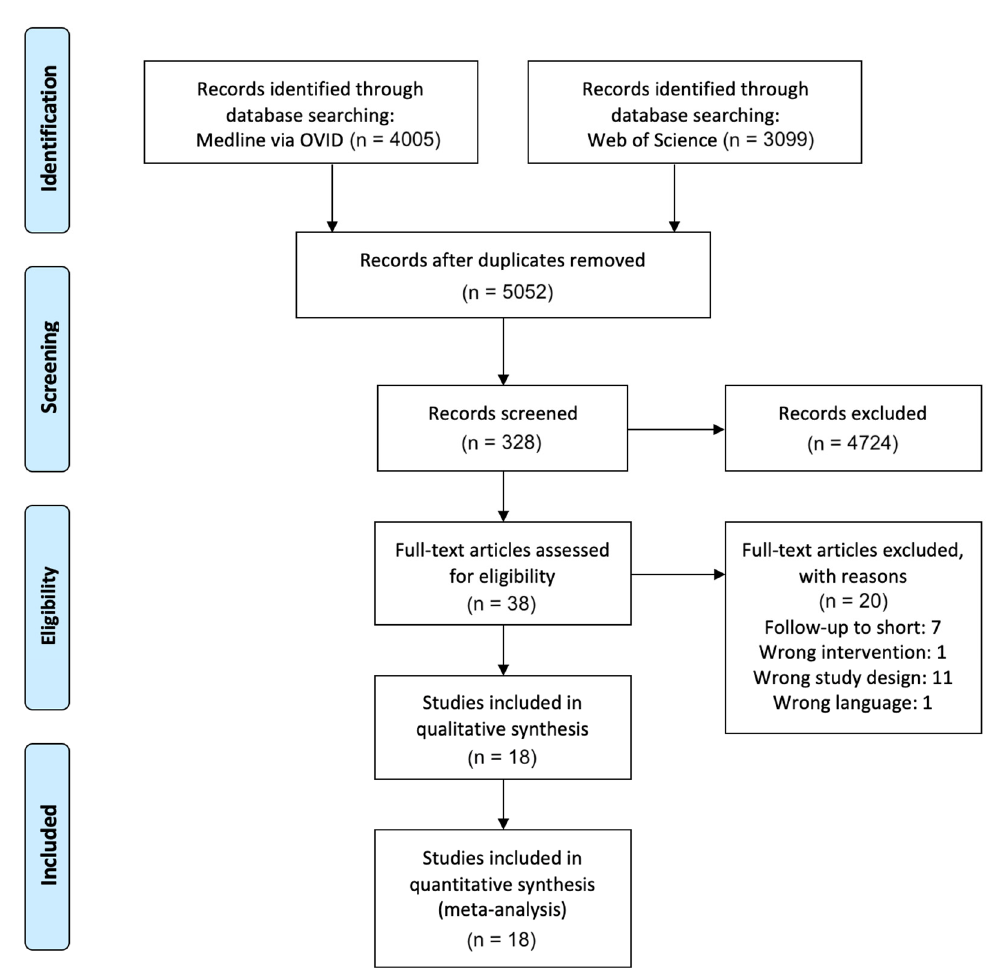
Figure 2. PRISMA flow diagram of the selection process.